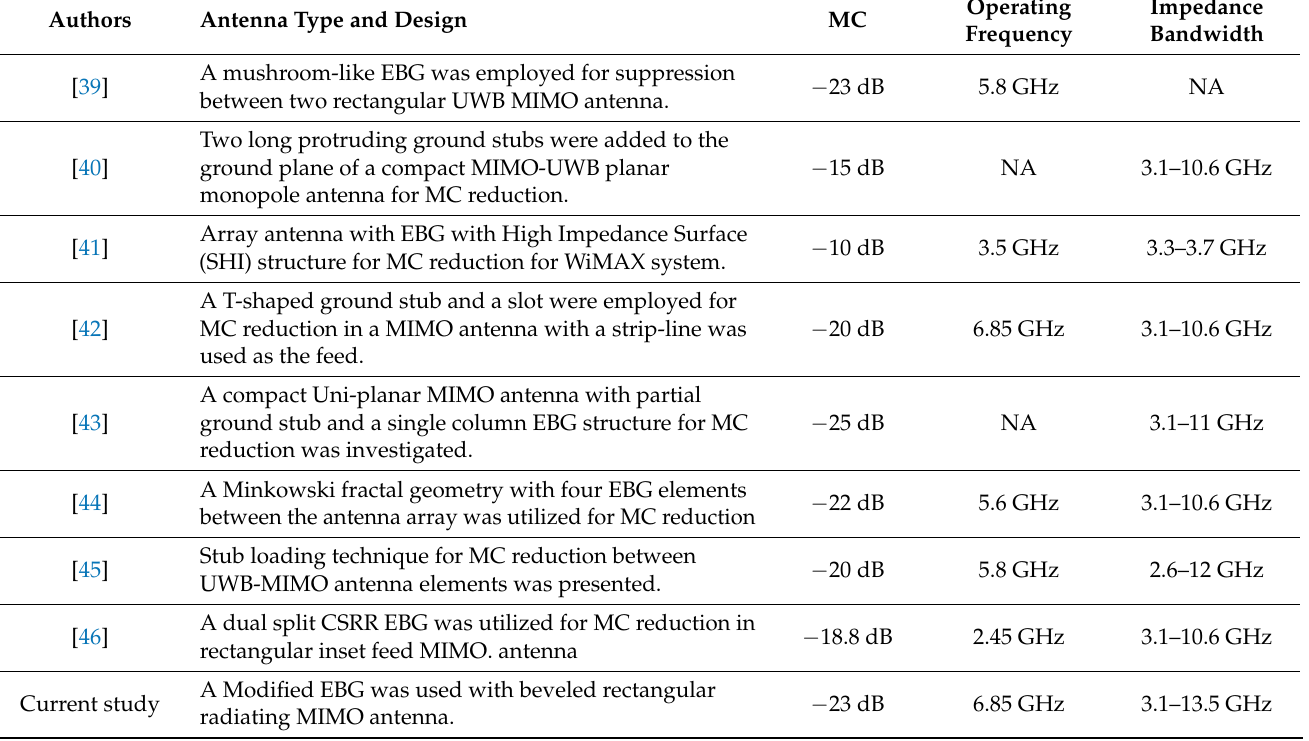
Table 4. Comparison of the current study for MC reduction with some related